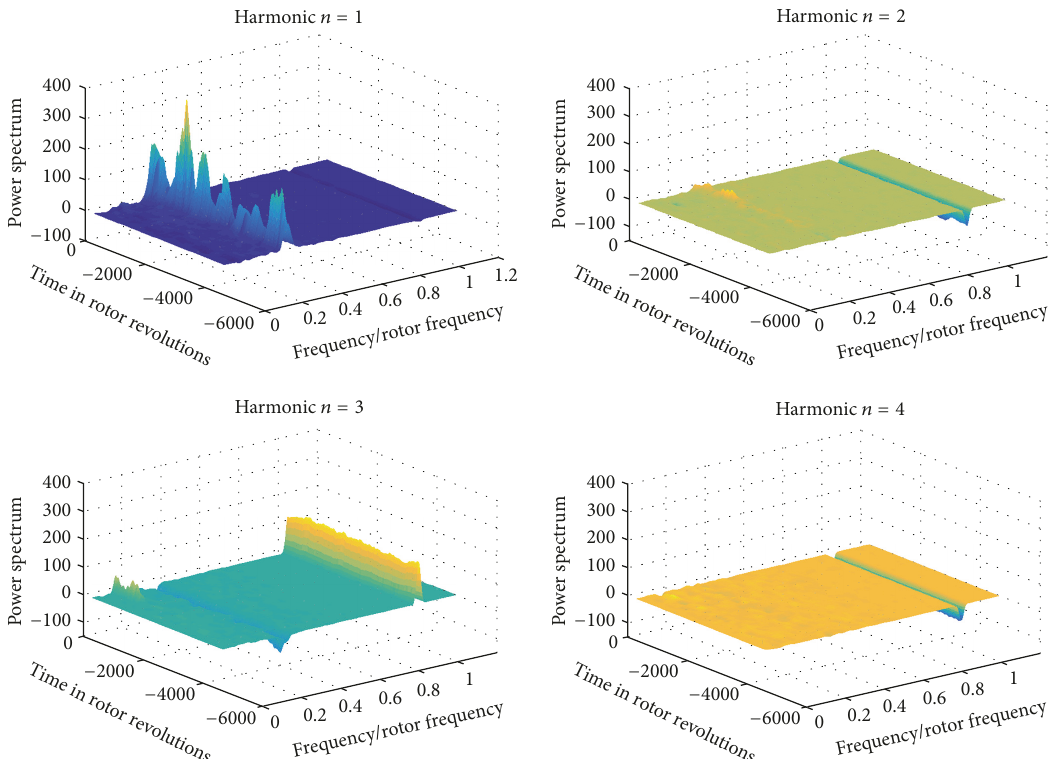
Figure 9: Spectrograms of the 1st, 2nd, 3rd, and 4th spatial harmonic pressure perturbations during stall ramp at 90% design speed without steam injection.